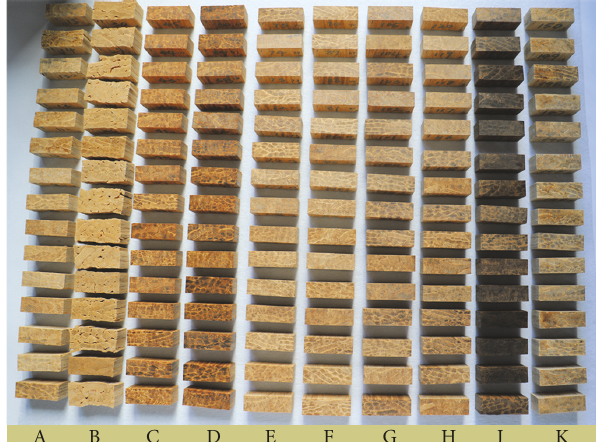
Figure 2: Digital photograph of bamboo scrimbers after media treatments.